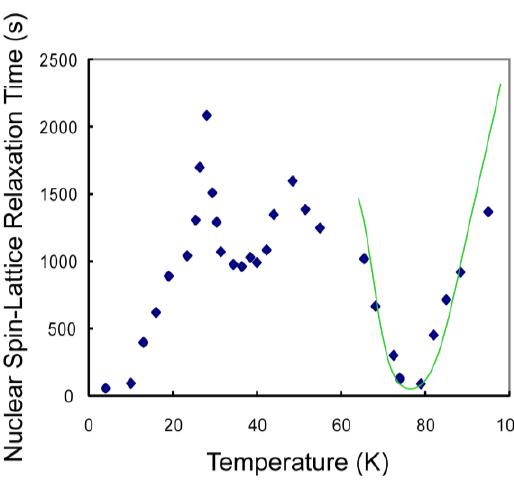
Figure 6. (Color on line) Fit of variation of the observed relaxation time with temperature for CH molecules in zeolite-13X at 78 K to thermal activation of intercage diffusion for 4 0.5 molecules per cage. The solid green line corresponds to an activation energy of 20.8 ± 1.5 kJ/mol. and a microscopic tunneling rate of 1.2 × 10 15 s −1